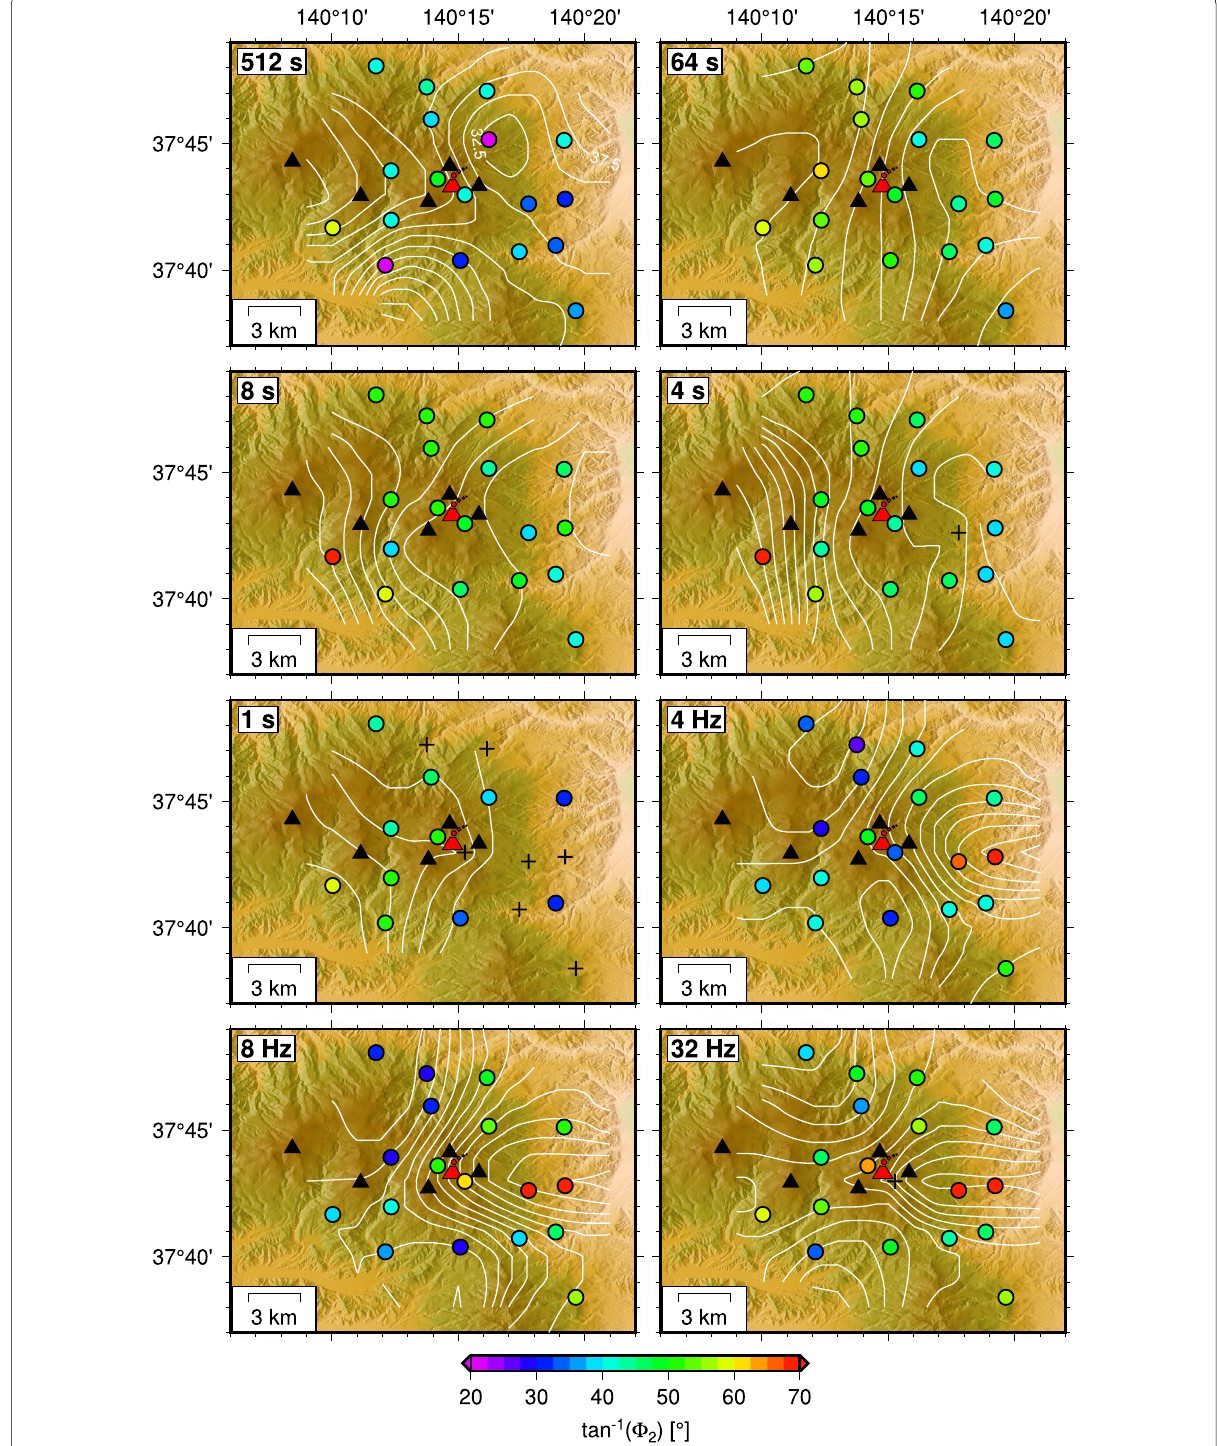
Fig. 2 Tan − 1 ( Φ 2 ) of each site at various frequencies or periods (colored circles). The white contour lines represent with 2.5° width. The black and red triangles are the same as in Fig.